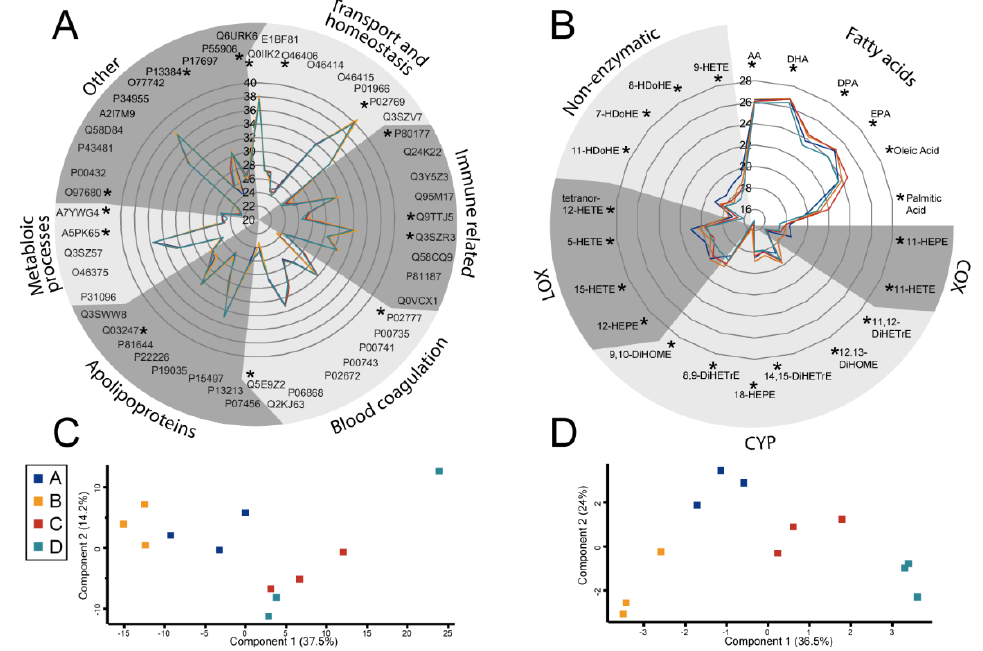
Figure 2. Radar plot for selected proteins ( A ) and fatty acids ( B ) identified in 4 different FCS batches without incubation with cells (baseline levels). Principal component analysis of protein ( C ) and eicosanoid ( D ) measurements of the same FCS batches, as indicated by different colors, demonstrates superior clustering in the case of eicosanoids. Asterisks mark significantly regulated molecules.